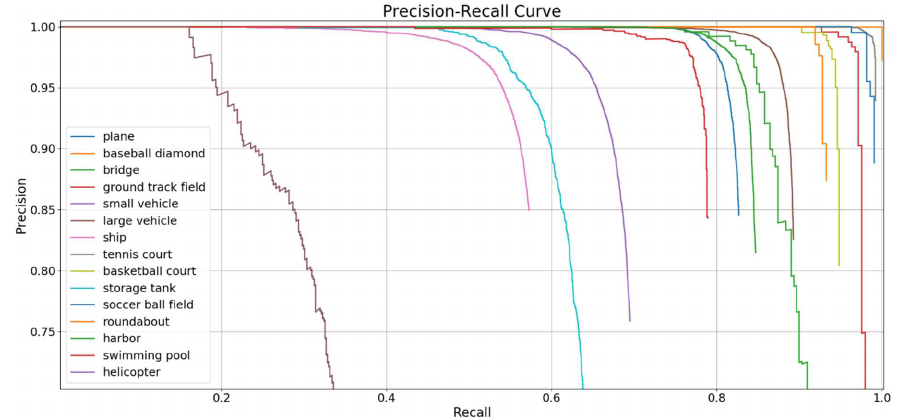
Figure 7. The precision-recall curves of different classes in the proposed method. Figure 8. The precision-recall curves of different classes in the proposed